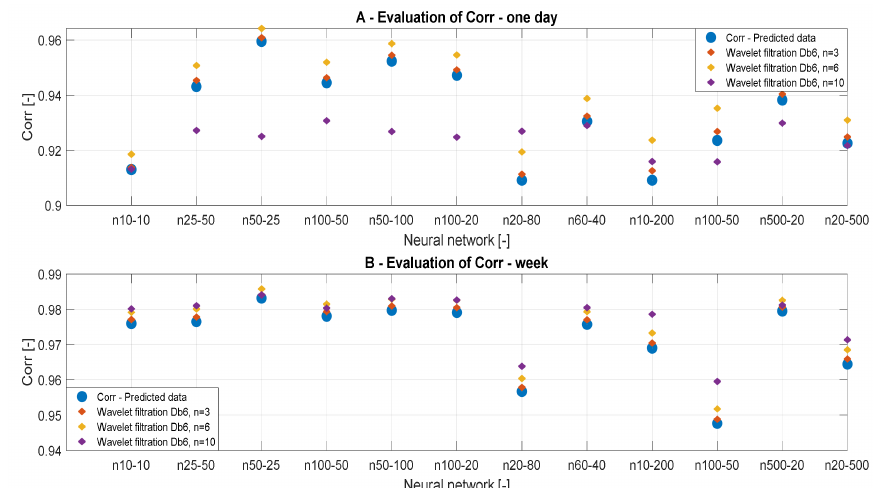
Figure 11. Correlation analysis of the reference signal and individual wavelet settings for two time periods: ( A ) one day and ( B ) week.